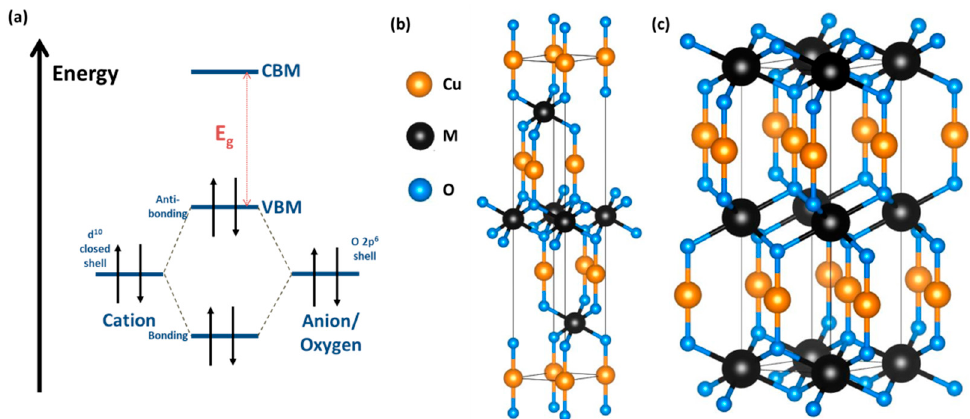
Figure 3. ( a ) Schematic diagram of the interaction between cation with a d 10 closed shell and oxygen anion, the anti-bonding formed by the hybridization give the valence band maximum (VBM) of the delafossites. Crystal structure of the delafossite of ( b ) rhombohedral 3R type and ( c ) hexagonal 2H type.